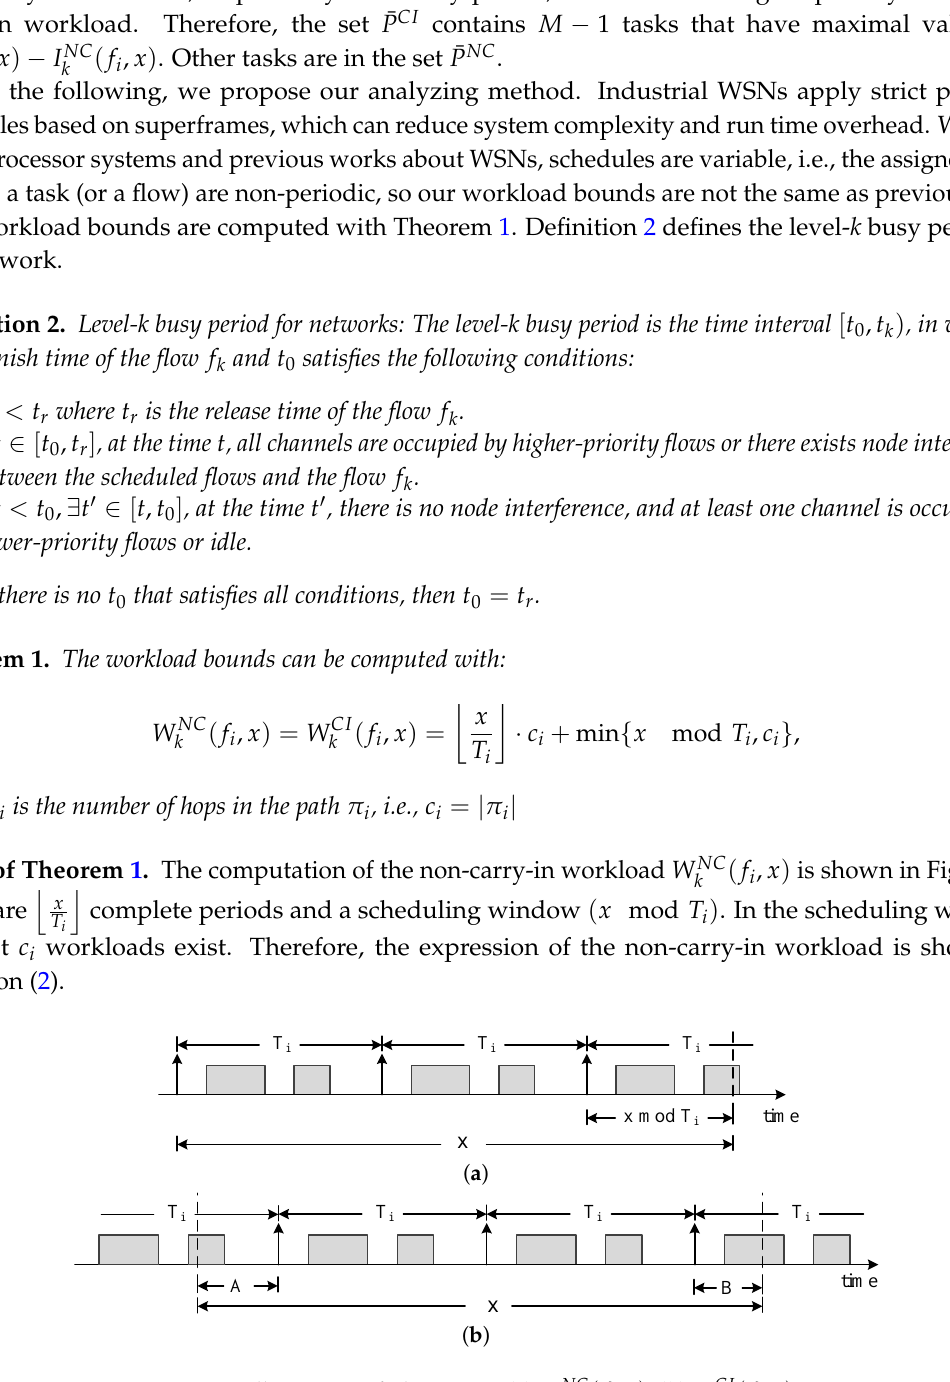
Figure 3. Illustration of Theorem 1. ( a ) W NC